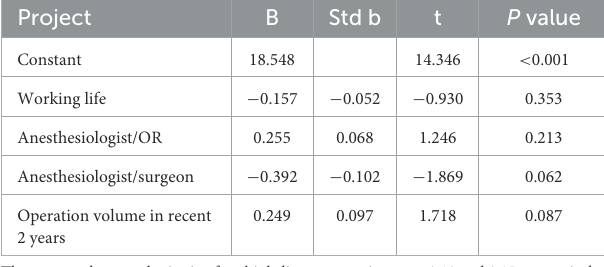
TABLE 4 Results of multiple linear regression of emotional exhaustion.